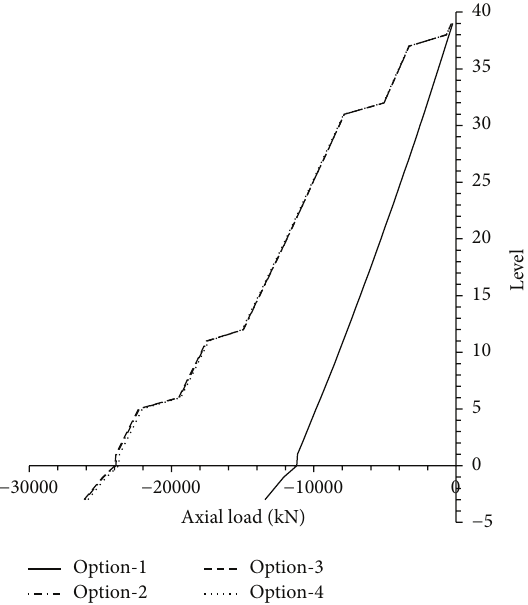
Figure 16: Axial load envelope in one typical